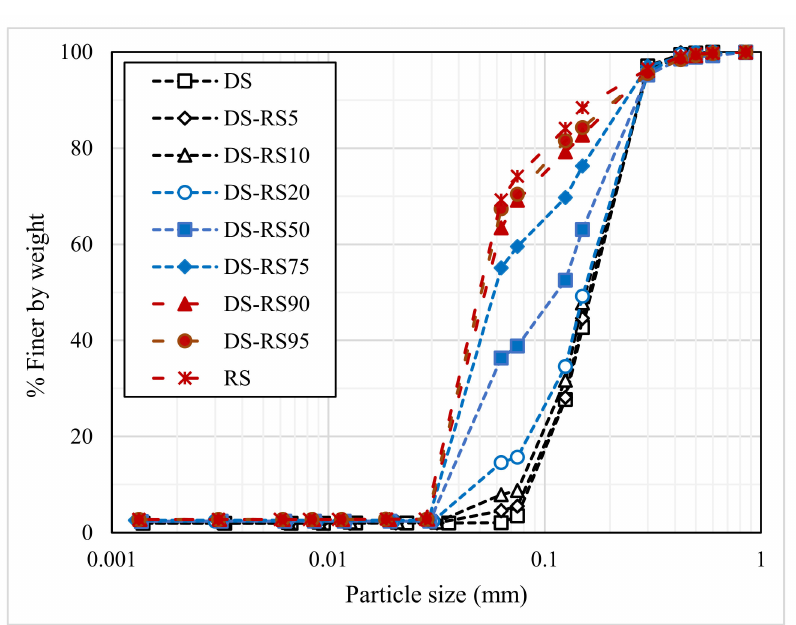
Figure 2. Particle size distributions of dune sand (DS), reservoir sediment (RS), and the prepared